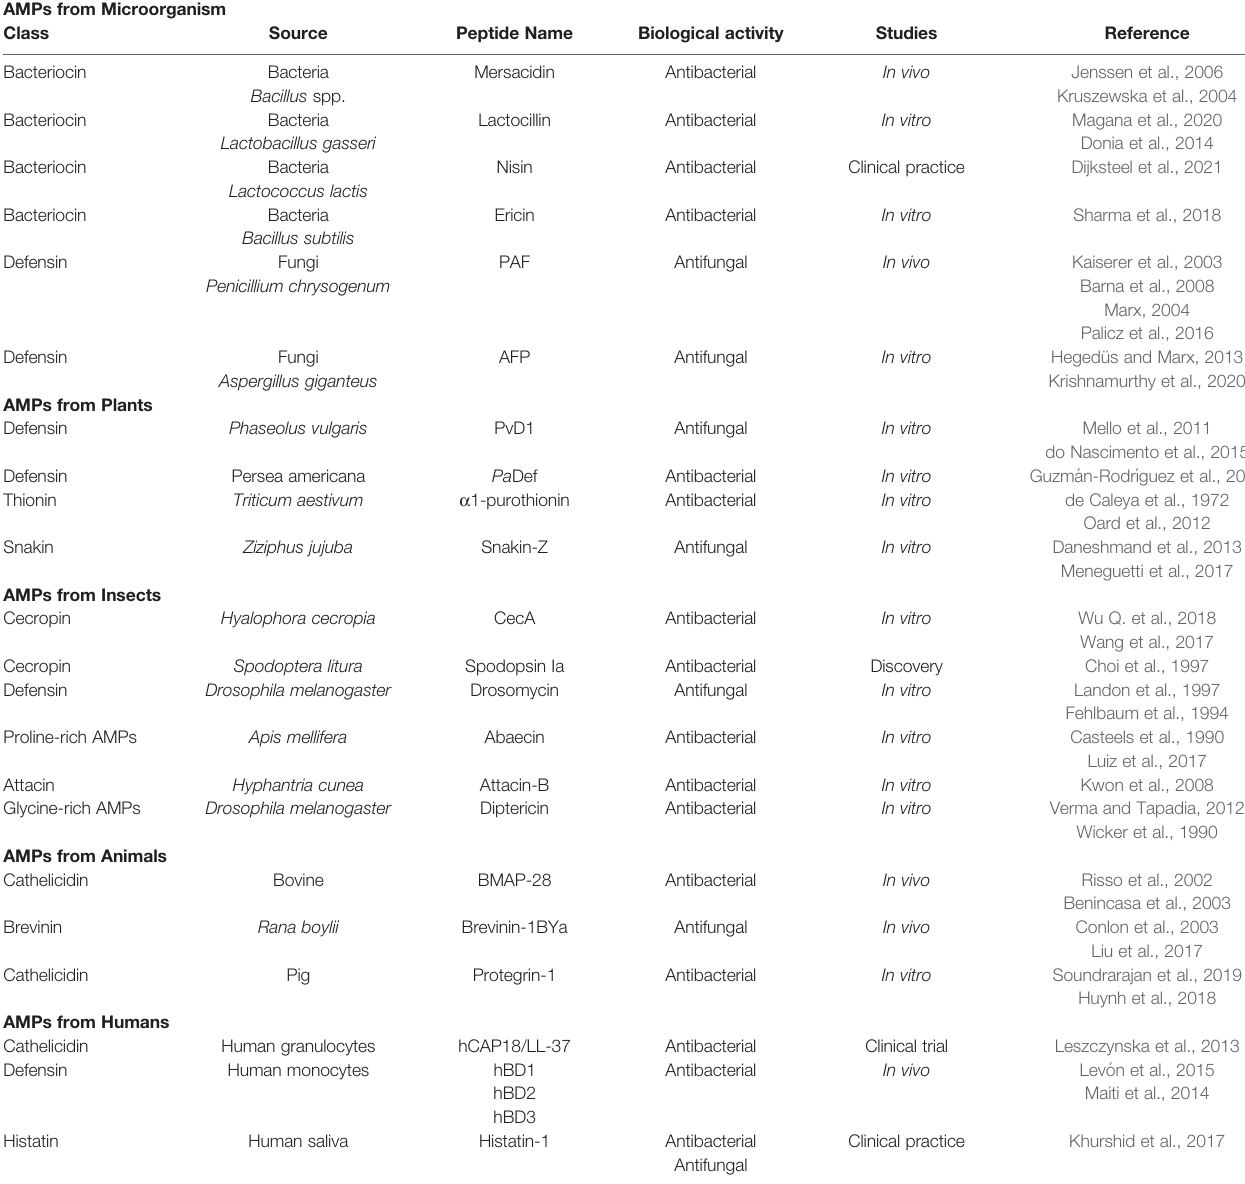
TABLE 1 | Overview of AMPs from different sources in nature and the current status of